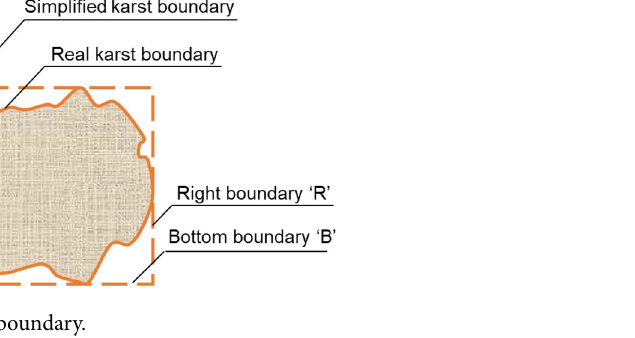
Figure 1. Simplified karst